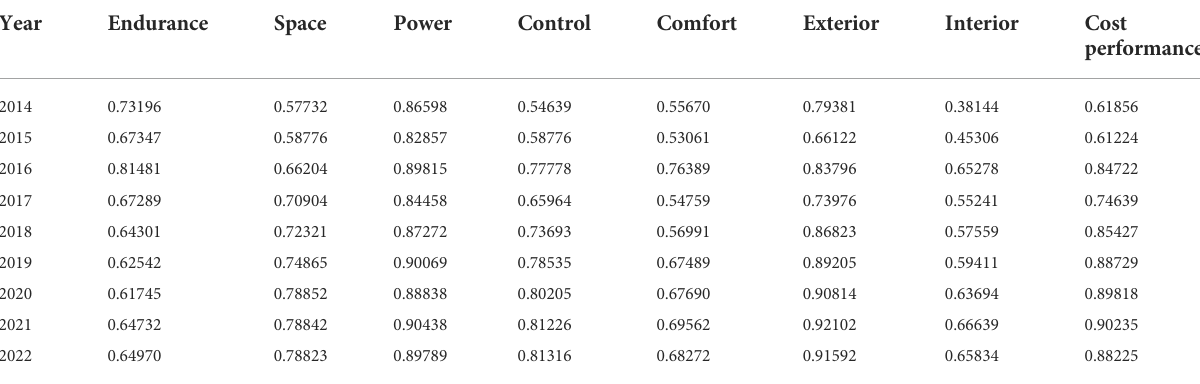
TABLE 1 Emotional scores in eight dimensions.